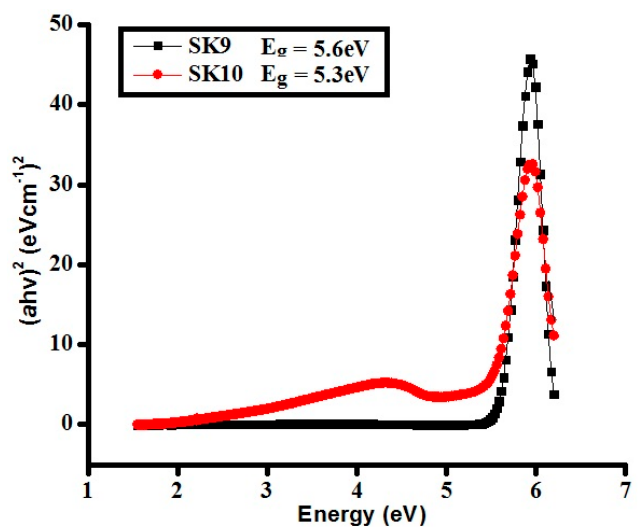
Figure 4. Tauc plots of synthesized perovskites ( SK9 – SK10 ).